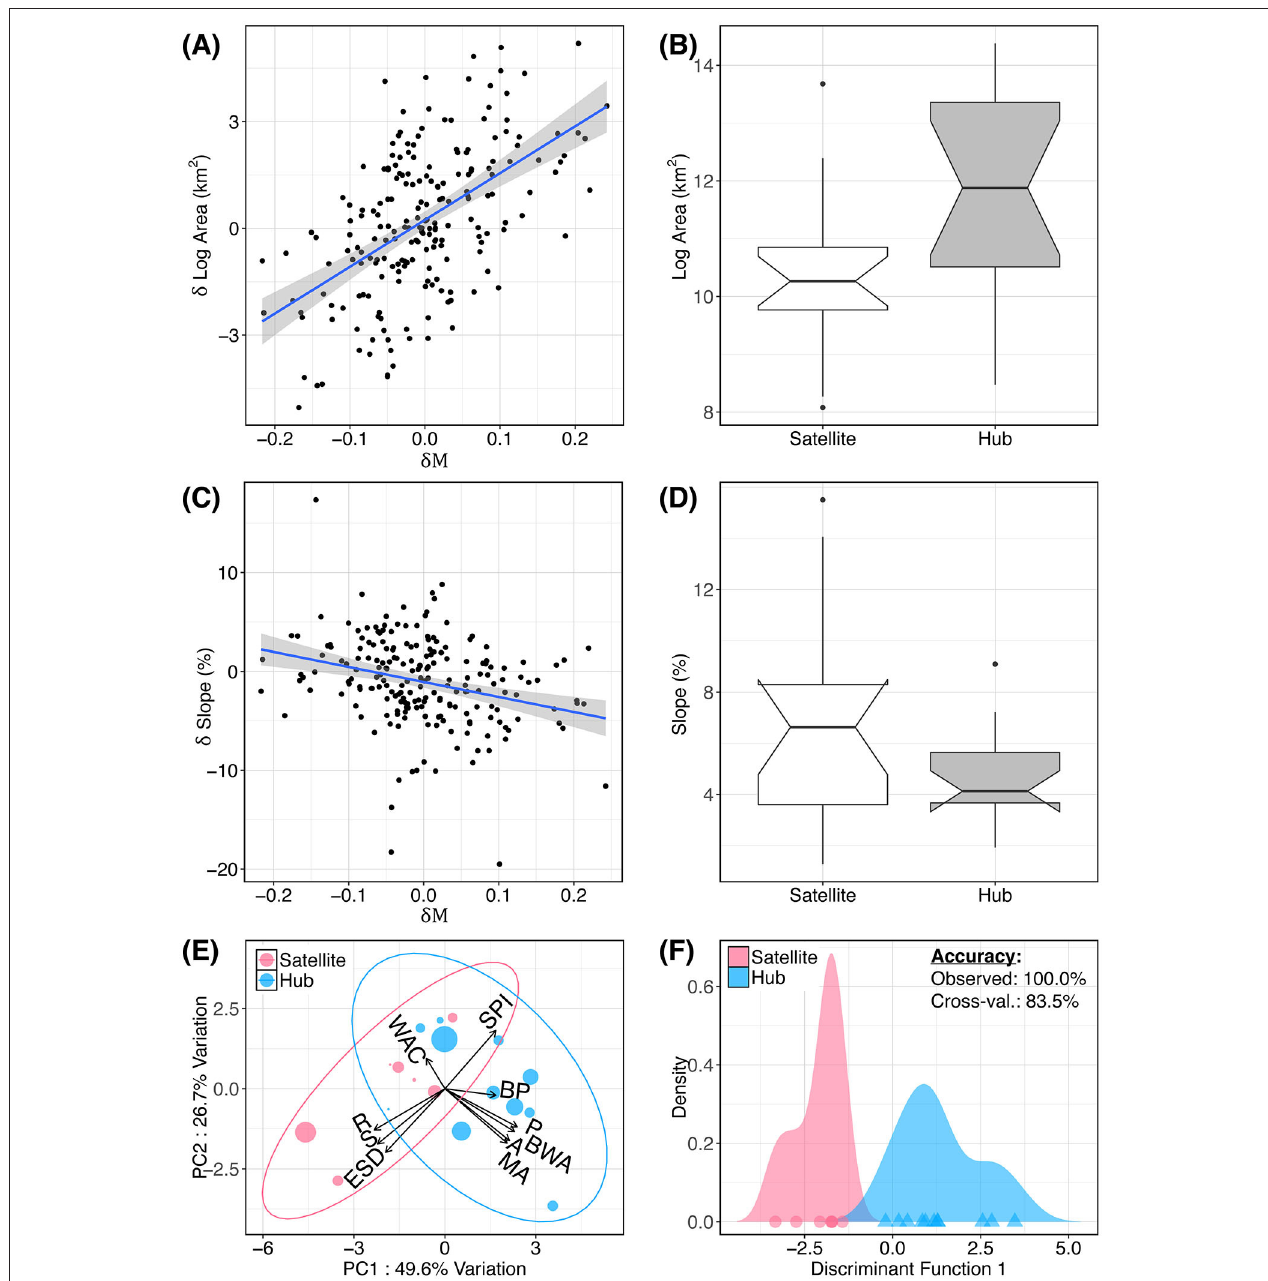
FIGURE 4 | Attributes of hub and satellite meadows. Hub (exceptional immigration rate) and satellite (exceptional emigration rate) meadows from Figure 3 are related to several environmental variables. Relationship between net relative migration ( δ M ) and relative difference in pairwise meadow area (A) and slope (C) are shown. In (B,D) , these pairwise differences are aggregated by meadow to show mean meadow area and slope for hubs and satellites (i.e., meadows having δ M more than one standard deviation from zero). (E) Principal components analysis (PCA) of meadow environment. Variables are described in Table 1 . (F) Linear discriminant analysis (LDA) showing the predictive accuracy of these 10 variables to discriminate between hubs and satellites.